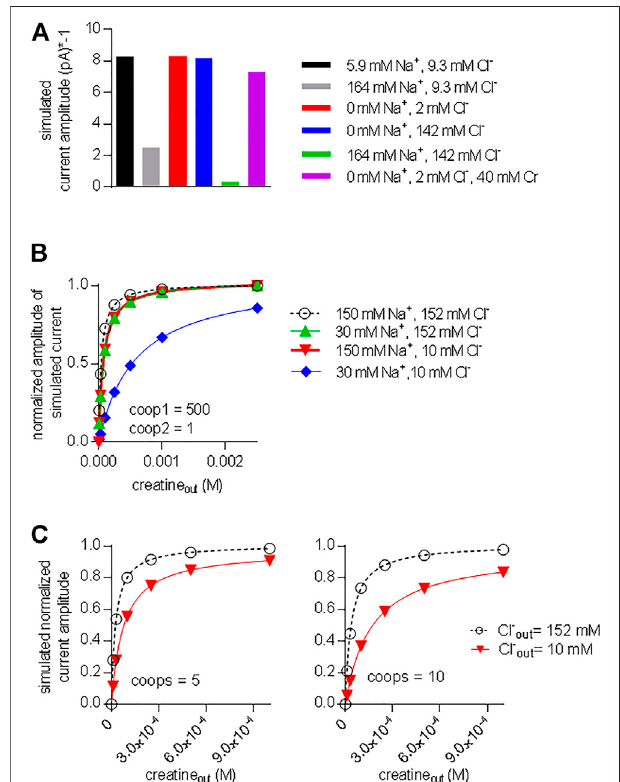
FIGURE 9 | A model with stable ternary complexes recapitulates the cooperativeaction ofco-substrateionsand onsubstrate-elicitedcurrents. (A) Synthetic currents elicited by 250 µM extracellular creatine were generated using the kinetic model outlined in Figure 7A with coop1 = 500 and coop 2 = 1 in the presence of the indicated intracellular ionic concentrations. The amplitude of this synthetic steady current was plotted to highlight the inhibition by sole elevation of intracellular Na + and the combined elevation of intracellular Na + and Cl − . (B) Synthetic concentration-response curves for currents (shown as normalized amplitude of the steady current) elicited by external creatine in the presence of the indicated ions, which recapitulate the experimental conditions employed Figure 6A . (C) Synthetic data were generated in the presence of 150 mM Na + and 152 mM Cl − (black curve) and 150 mM Na + and 10 mM Cl − (red curve) by the kinetic model shown in Figure7A withcoop1andcoop2=5(left handgraph)and coop1and coop2 = 10 (right hand graph). In these instances, lowering the extracellular concentration of only one co-substrate (i.e. Cl − : from 152 to 10 mM) was suf fi cient to produce a pronounced right shift of the EC 50 value for current